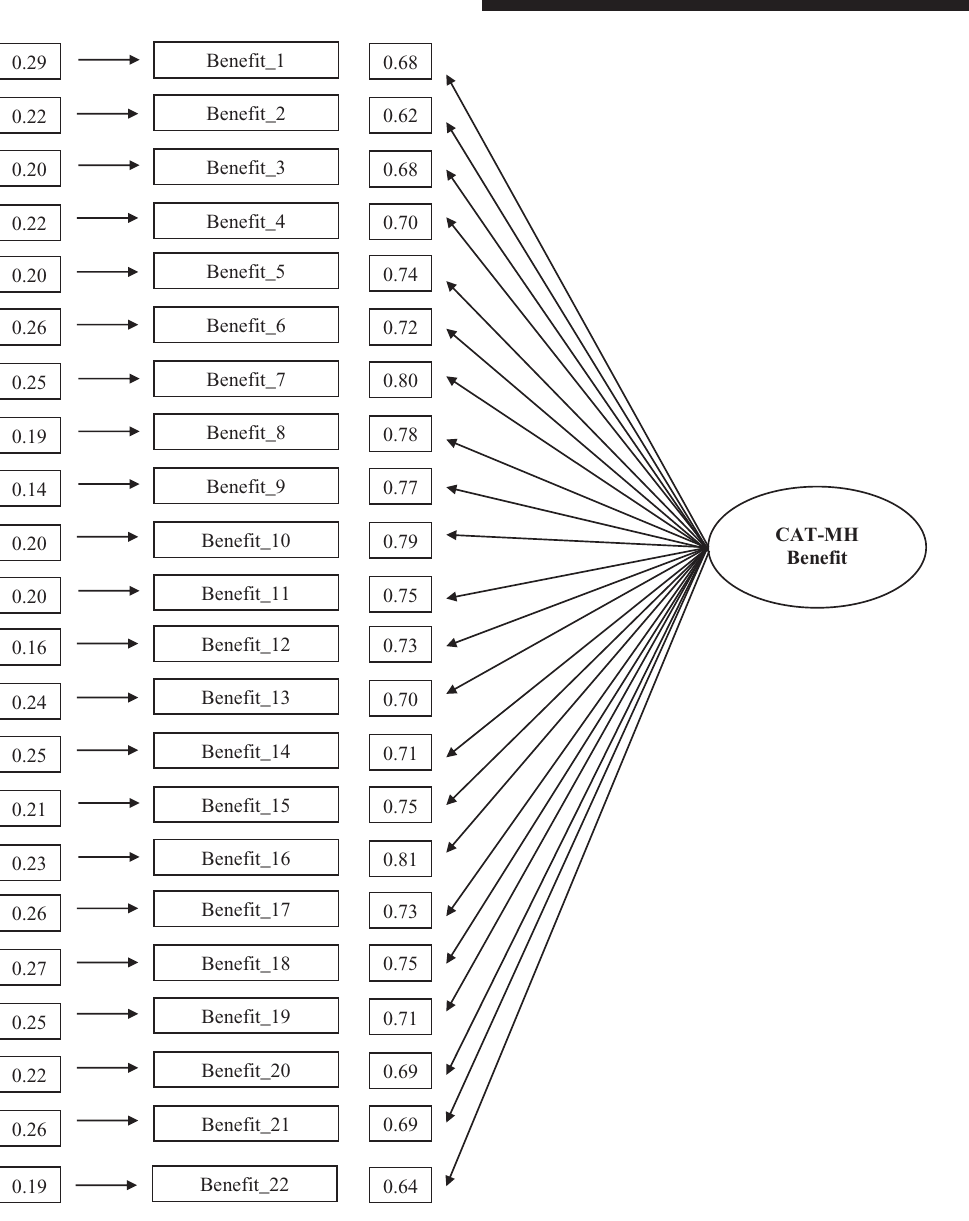
Figure 2. Confirmatory factor analysis (The Section on Benefits of Additional